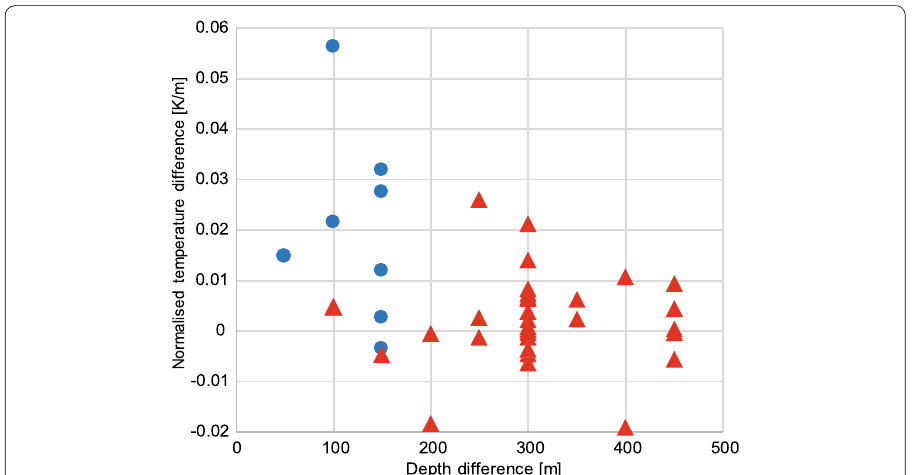
Fig. 6 Temperature difference between measured and extrapolated log temperatures. Normalised temperature difference between measured and extrapolated log temperatures versus the depth difference between the measured value and the topmost value used for the extrapolation. Blue dots: extrapolations using values from a depth of 200 m downwards; red triangles: extrapolations using only values from a depth